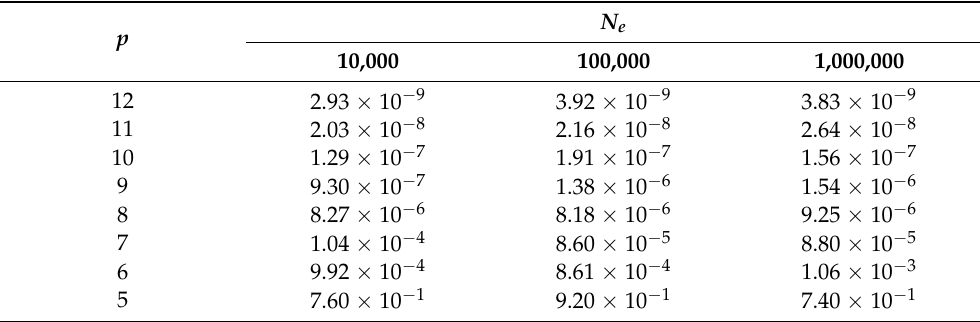
Table 1. The max residual of the RBF interpolant (biharmonic spline) using the fast multipole method with different expansion orders (the number of source points N s is 10,000). N e is the number of evaluation points.